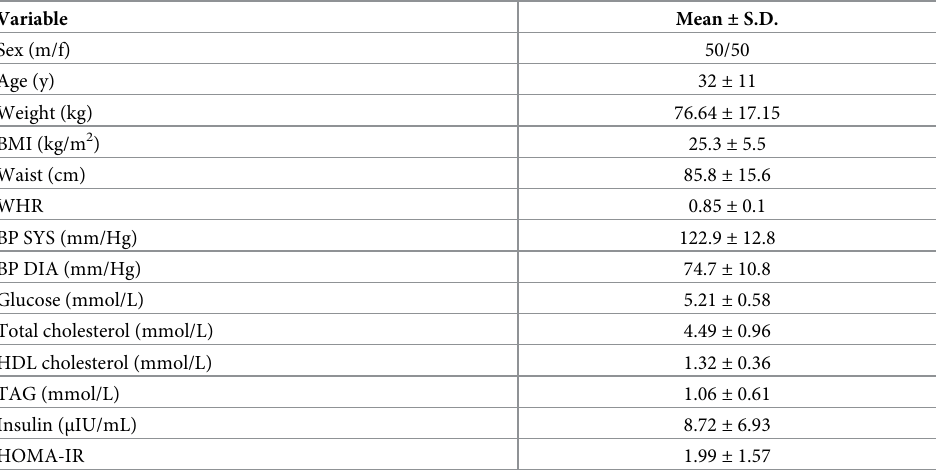
Table 1. Baseline characteristics of MECHE cohort (n = 100).